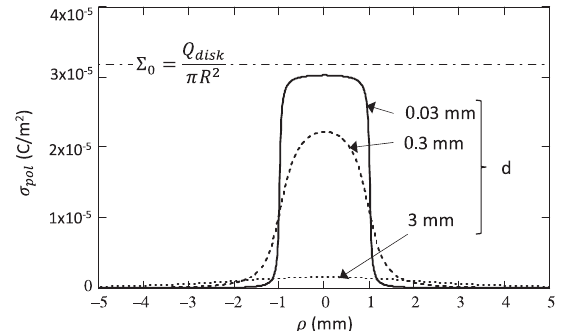
FIG. 9. The polarization charge density on the cathode surface ¼ 100 pC. The calcu- for a R ¼ 1 mm radius disk with Q disk lations assume q 0 ¼ − q . Lineout profiles of the surface charge density are shown for the disk at d ¼ 0 . 03 , 0.3, and 3 mm from the cathode. The surface charge density of the disk, Σ 0 , is shown with a horizontal dash-dotted